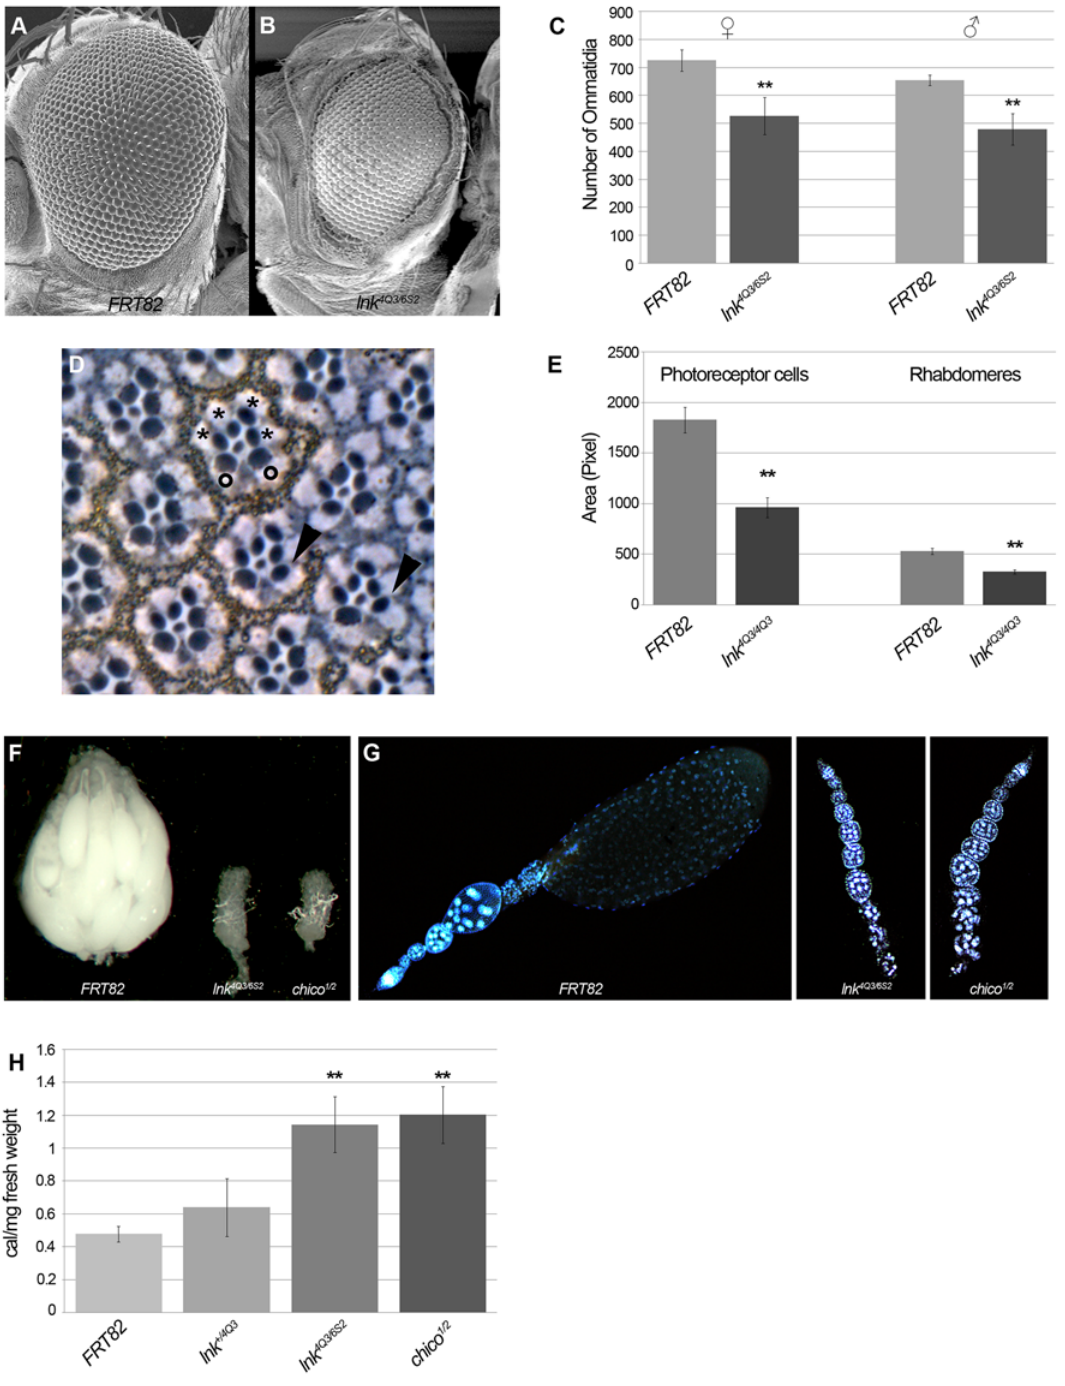
Figure 2. Drosophilalnk regulates cell number and cell size, reminiscent of low IIS activity. SEM picture of a wild-type Drosophila head (A) compared to the head of a homozygous lnk mutant fly (B). The eye of the lnk mutant is smaller due to fewer and smaller ommatidia. (C) Whereas wild-type eyes consist of more than 700 ommatidia, the number of ommatidia is reduced to about 500 in lnk mutants. (D) Tangential sections through mosaic eyes consisting of homozygous mutant photoreceptors (marked by the absence of pigment) surrounded by heterozygous tissue. Ommatidia containing both wild-type and small homozygous lnk mutant photoreceptor cells (arrowheads) can be observed, pointing to a cell autonomous role of lnk in cell size regulation (wild-type cells are marked by circles and mutant cells by asterisks in a representative ommatidium). (E) The sizes of photoreceptor cells and of rhabdomeres are reduced in lnk mutant ommatidia compared to wild type. (F) lnk mutant females are sterile due to an arrest in oogenesis. Ovaries of homozygous lnk females are small and contain only few oocytes developed to previtellogenic stages (G). The ovarioles of lnk mutant females resemble those of chico mutants (G). (H) The lipid levels of lnk mutant males are strongly elevated compared to wild type, similar to the levels measured in chico mutant flies. Significant changes relative to the respective controls ( p # 0.01, Student’s t-test) are marked by double asterisks; error bars represent the standard deviation; n=8 in (C), n=9 in (E), n=10 in (H).